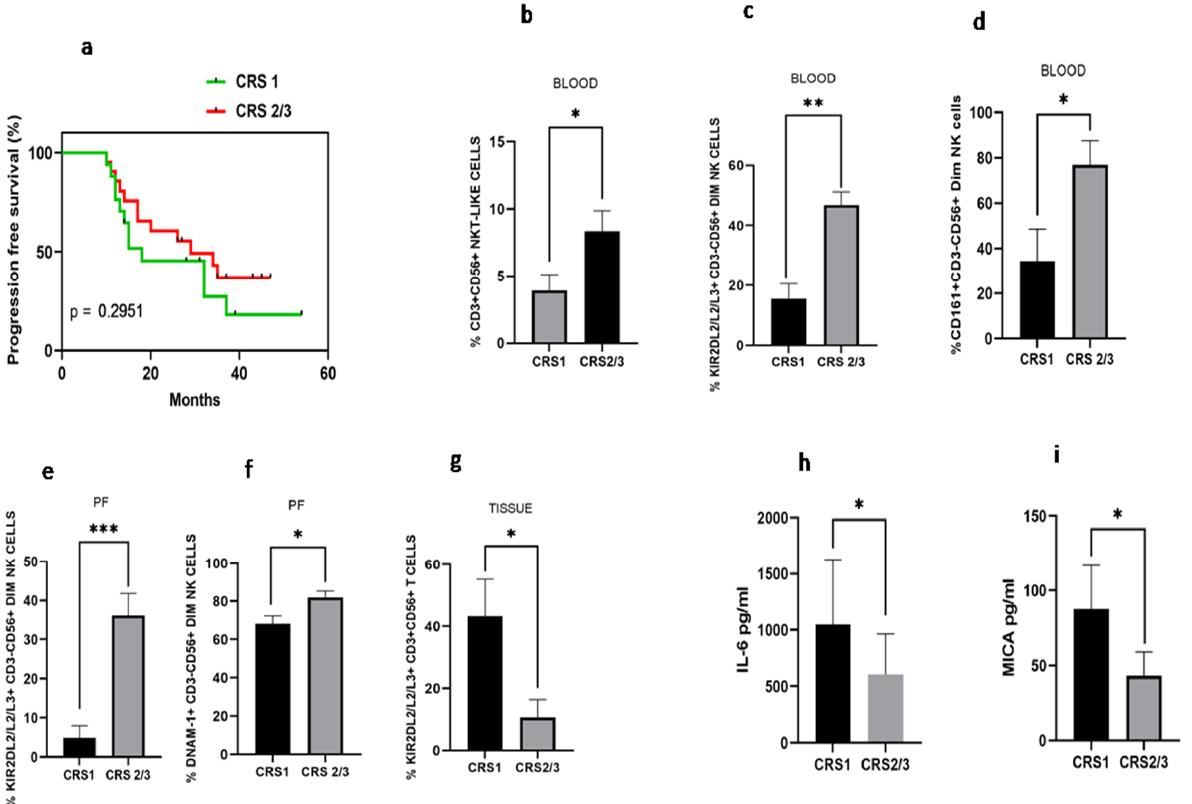
Figure 7. ( a ) Progression-free survival with Chemo response score 1 (CRS 1) and Chemo response score 2/3 (CRS 2/3); NKT-like cells; NK; ( d ) CD161+CD3+CD56+ Dim NK cells in peripheral blood; ( e ) KIR2DL2/L3/S3+CD3-CD56+ Dim NK and ( f ) DNAM-1+ CD3-CD56+ Dim NK cells in Peritoneal fluid; ( g ) KIR2DL2/L3/S3+CD3+CD56-T cells in tissue; ( h ) IL-6 level in peritoneal fluid; and ( i ) serum MICA level of patients with CRS1 and CRS 2/3 group.* p < 0.05; ** p < 0.01; *** p <